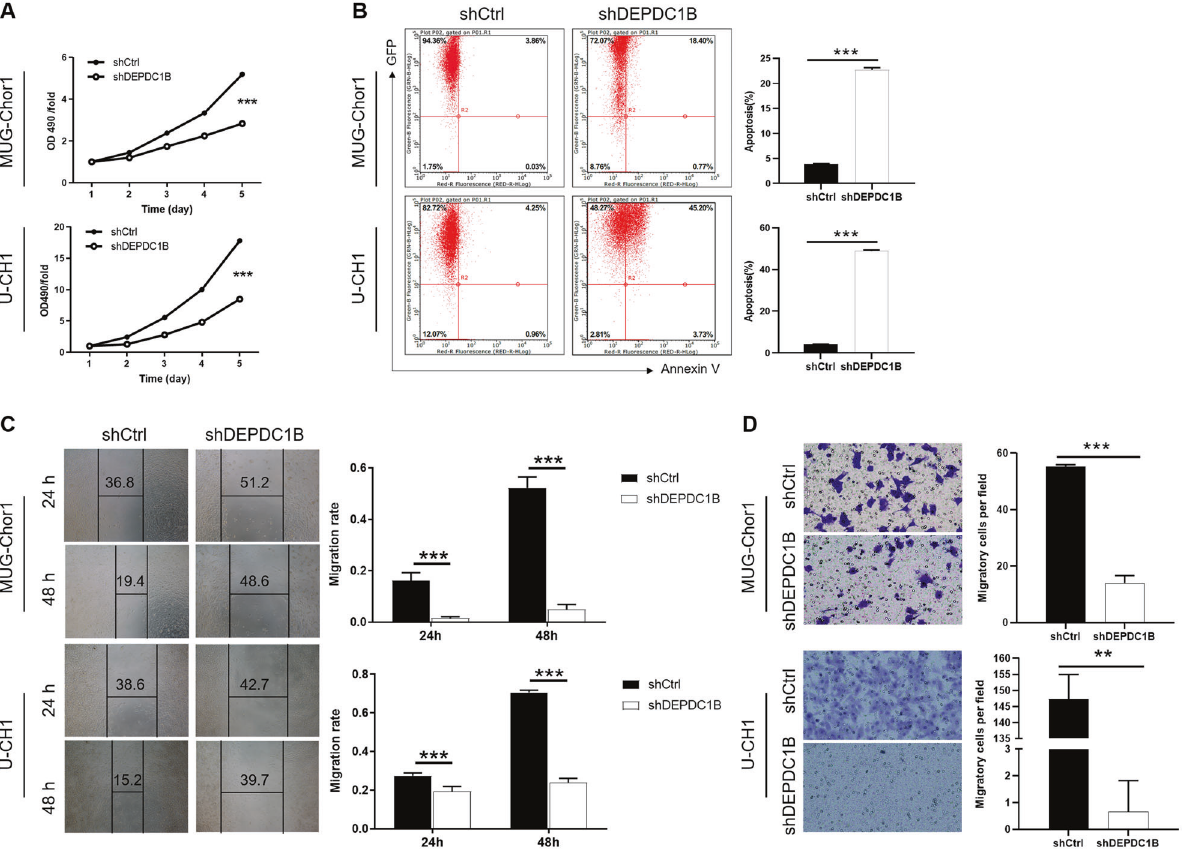
Fig. 1 Knockdown of DEPDC1B inhibits cell proliferation and migration, promotes apoptosis in chordoma cells. A Cell proliferation of U-CH1 and MUG-Chor1 cells with or without knockdown of DEPDC1B was evaluated by MTT assay. B Flow cytometry analysis based on Annexin V-APC staining was utilized to detect cell apoptotic ratio for U-CH1 and MUG-Chor1 cells. C , D Cell migration of U-CH1 and MUG- Chor1 cells with or without knockdown of DEPDC1B was evaluated by Transwell assay ( D ) and wound-healing assay ( E ). The presented results were representative of experiments repeated at least three times. Data were represented as mean ± SD. ** P < 0.01, *** P <